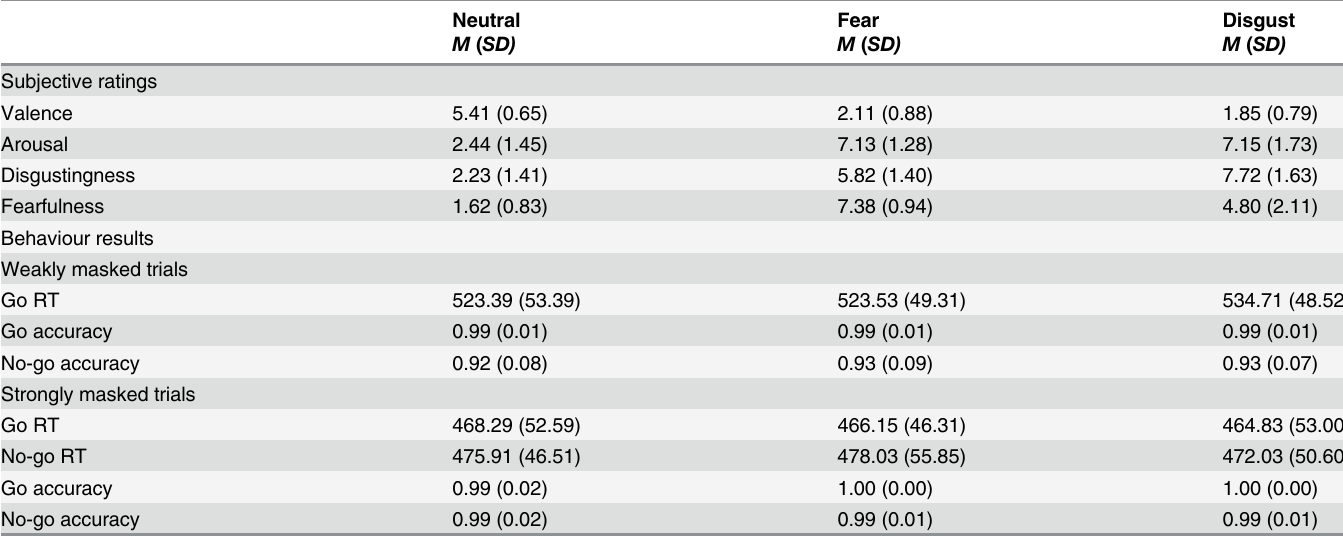
Table 1. Subjective Ratings of Stimuli and Behavioural Results for Go/No-Go